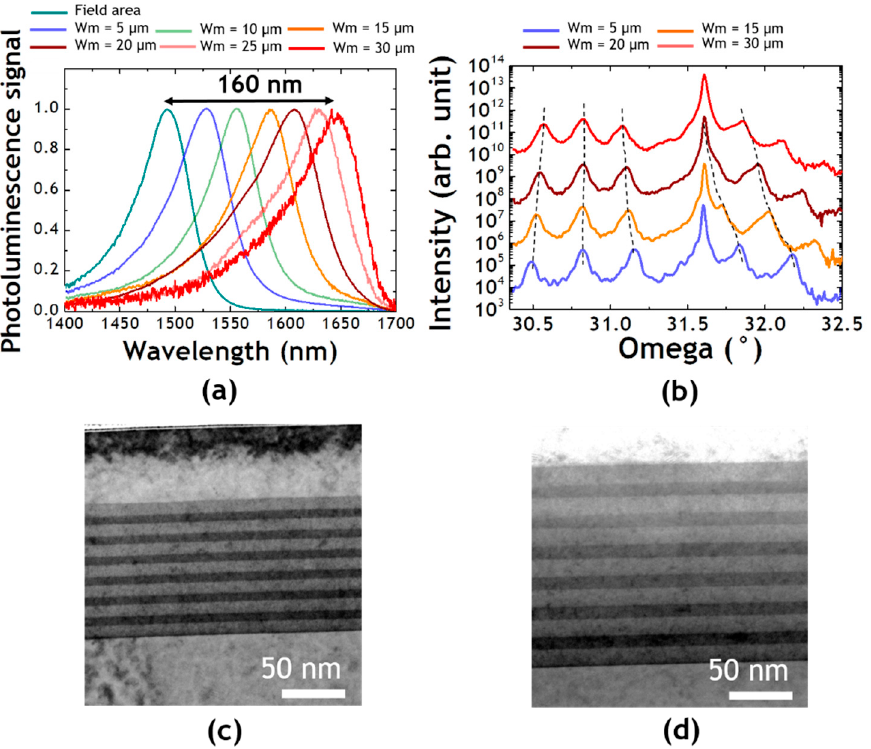
Figure 8. Morphologic characterizations of the selectively grown AlGaInAs-based MQW structures on InPoSi: ( a ) PL measurements for SAG masks’ widths ranging from 5 µm to 30 µm; ( b ) HRXRD profiles obtained with a micro-focus X-ray source; Cross-section TEM image obtained in SAG regions obtained with ( c ) W m = 5 µm; ( d ) W m = 30 µm.